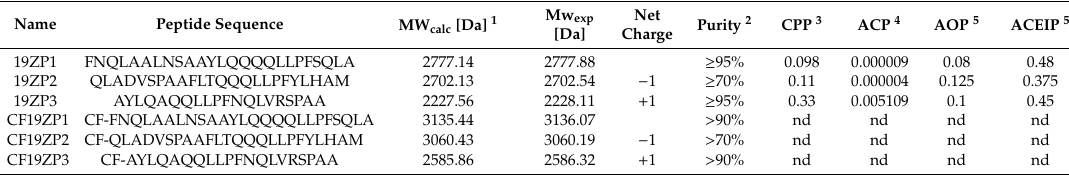
Table 1. Name and analytical data of the peptide sample